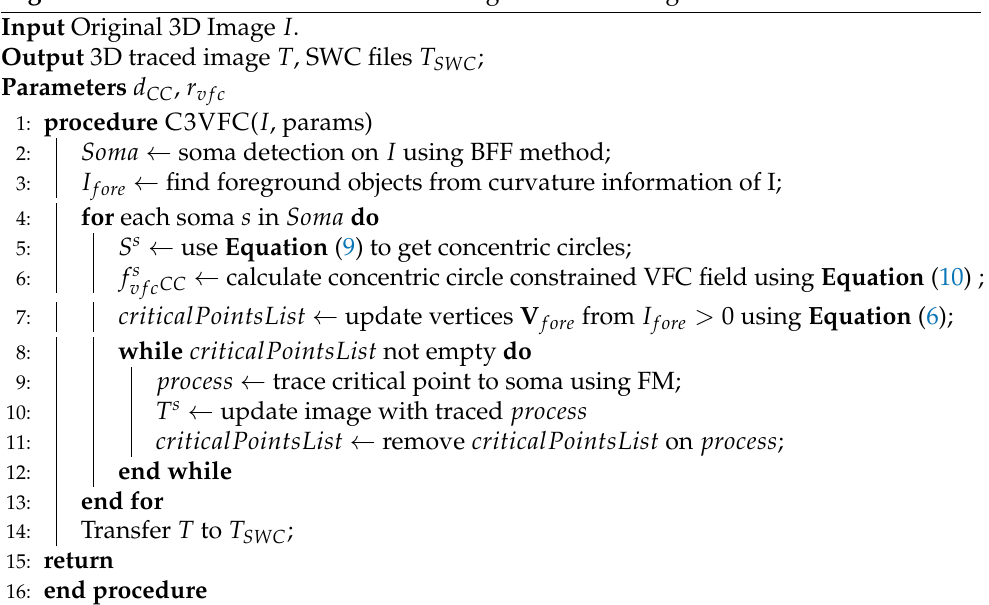
Algorithm 1 Procedure for C3VFC for tracing medial axis of